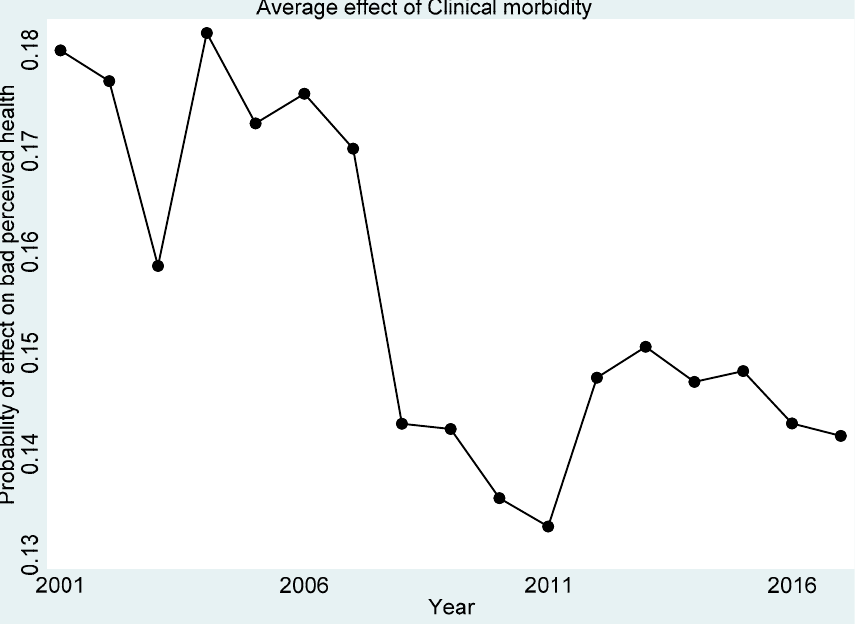
Figure 2. Probability of effects on “bad” perceived health from the average effect of clinical morbid- ity.